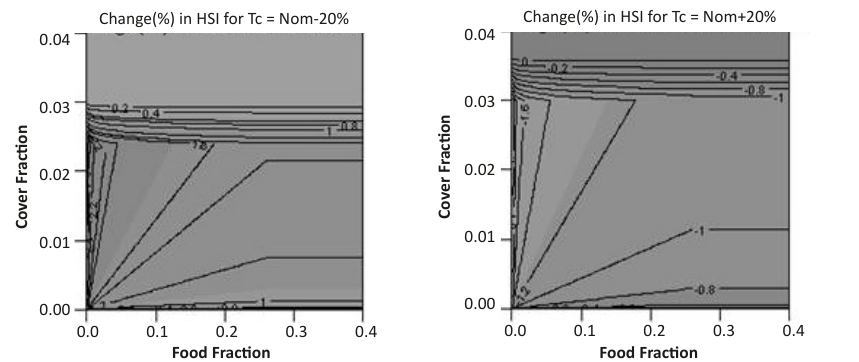
Figure 4. Effects of varying parameter Tc . = Slide